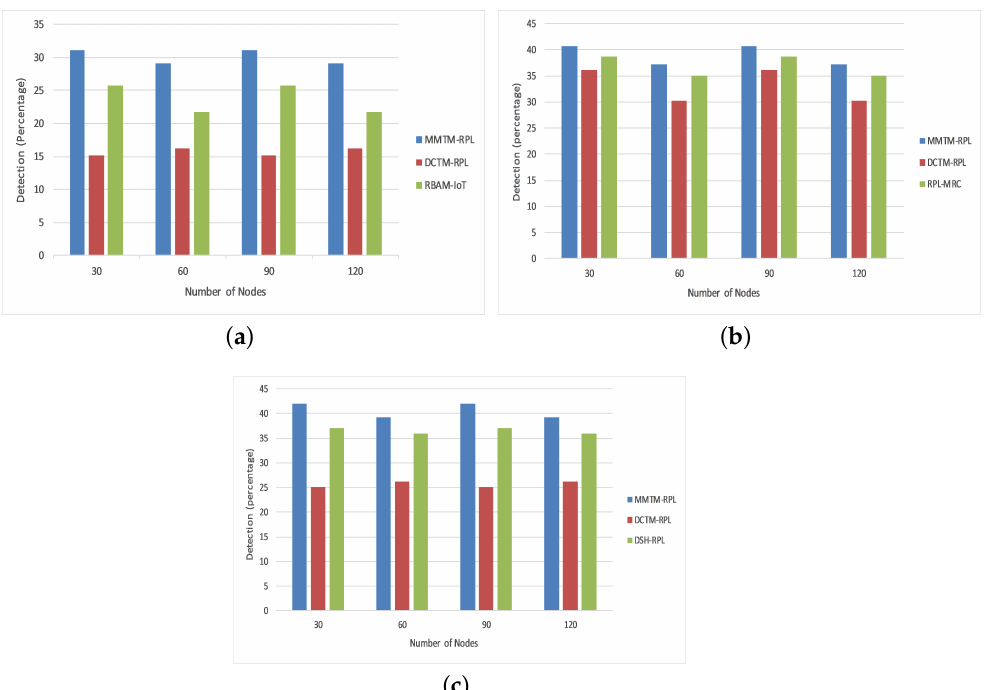
Figure 7. Comparison of attack detection rate for different attacks: ( a ) Rank attack, ( b ) Sybil attack, and ( c ) Sinkhole